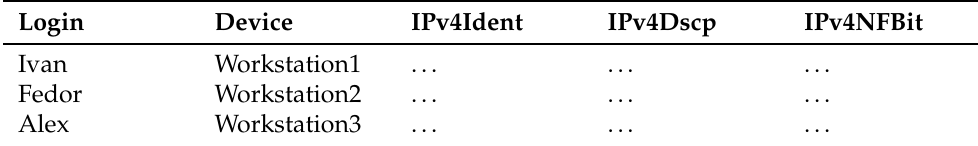
Table 8. Example of query results of the algorithm for Feature